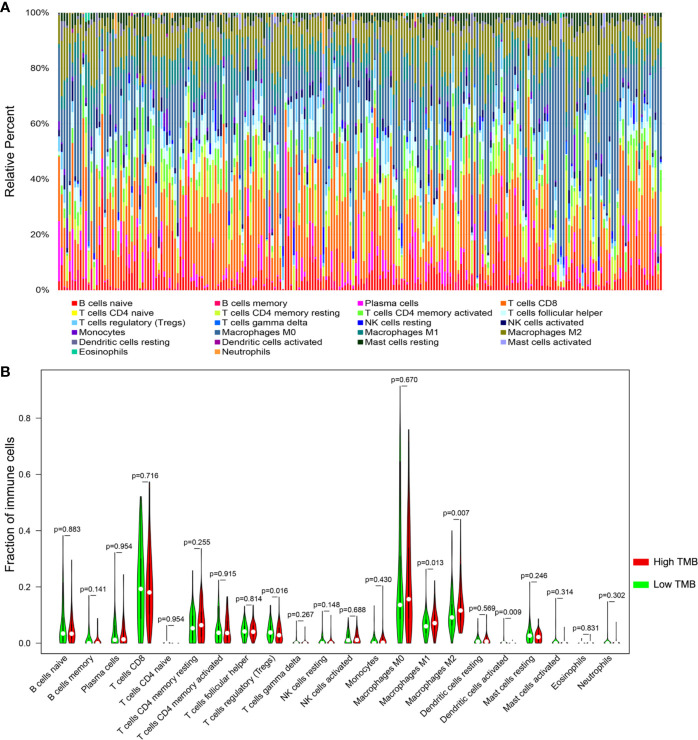
Comparisons of 22 important immune fractions between high- and low-TMB groups. (A) The specific 22 immune fractions represented by various colors in each sample were shown in bar plot. (B) Wilcoxon rank-sum test revealed that the infiltrations levels of regulatory T cell and dendritic activated cells in high-TMB group were lower than that in low-TMB group, while M1 and M2 macrophages showed the opposite trend. TMB, tumor mutation burden.